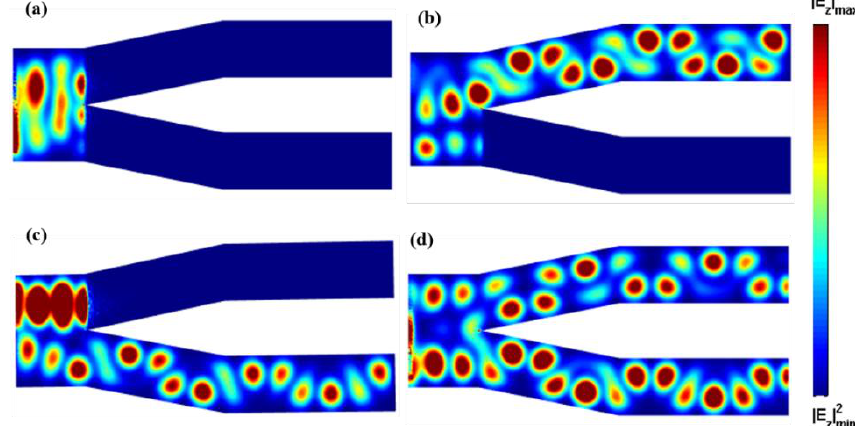
Figure 3. Distributions of | E z | 2 in the x - y plane of the Y-branch switch, in the output logical state of ( a ) “00”; ( b ) “01”; ( c ) “10”; and ( d ) “11”.